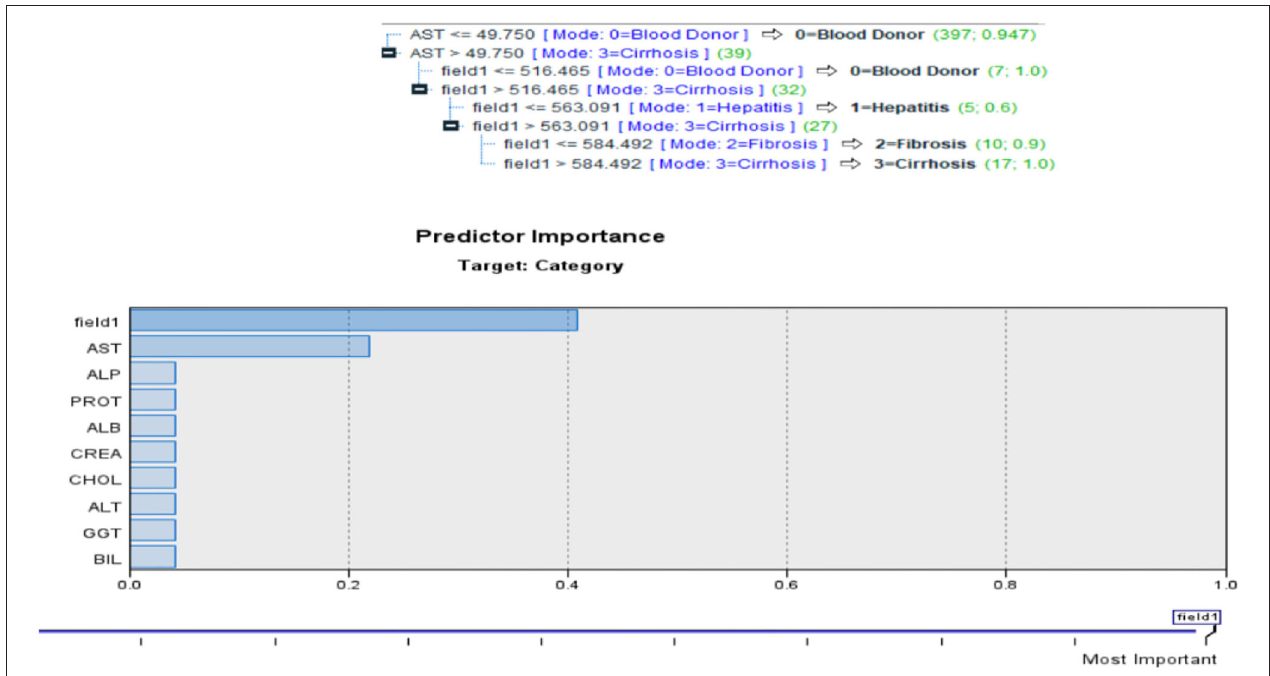
FIGURE 7 | QUEST for current